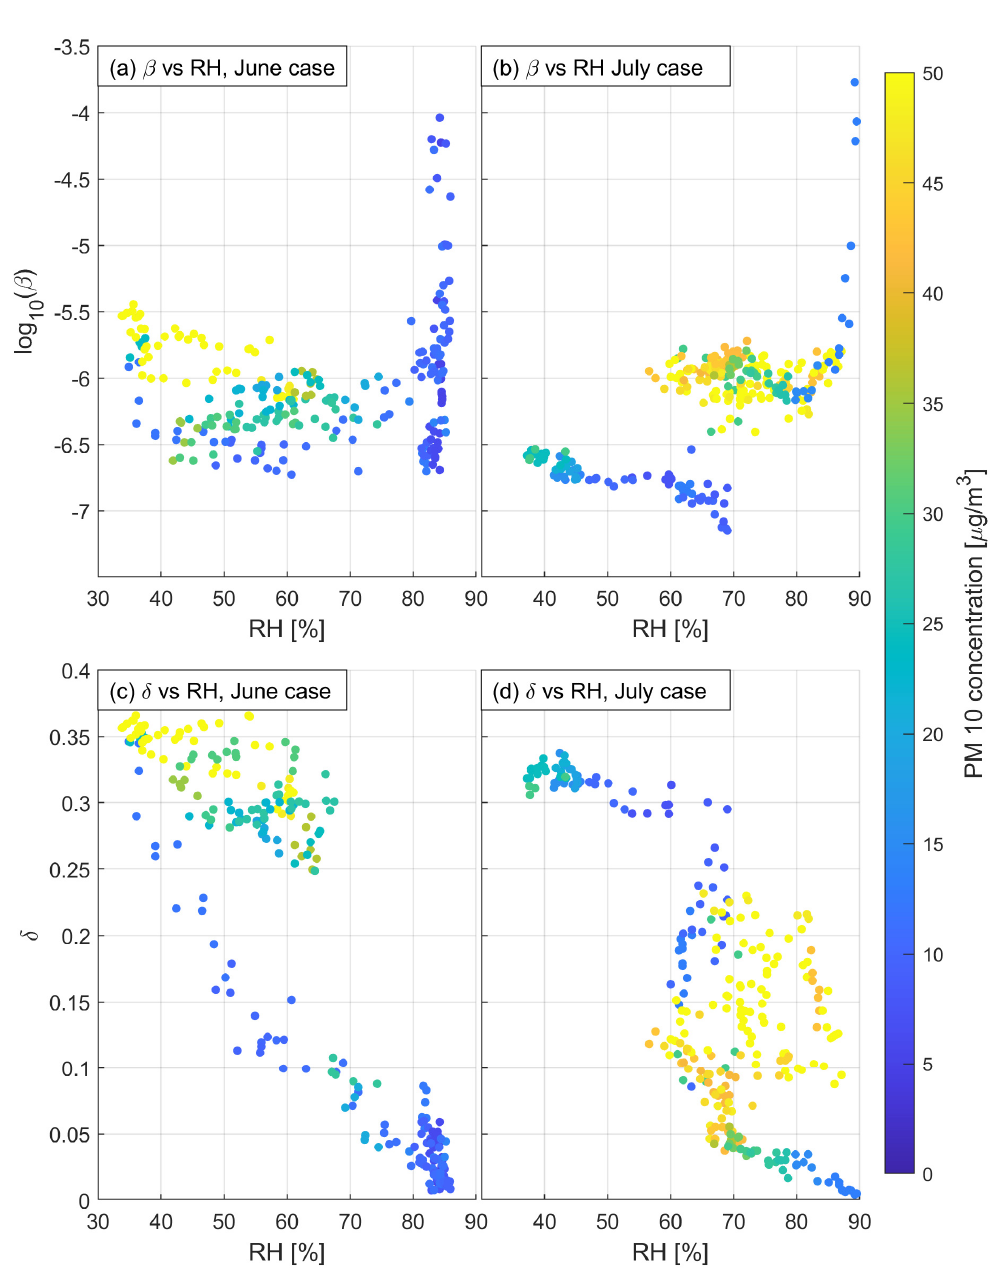
Figure 17. Backscatter coe ffi cient ( β ) and depolarization ratio ( δ ) from lidar v.s. relative humidity (RH). RH is measured by the weather station every 10 min, and lidar data is averaged with the same temporal resolution. RH is measured 2 m above the surface, lidar data only use the first range gate (200 m). The colour indicates the PM 10